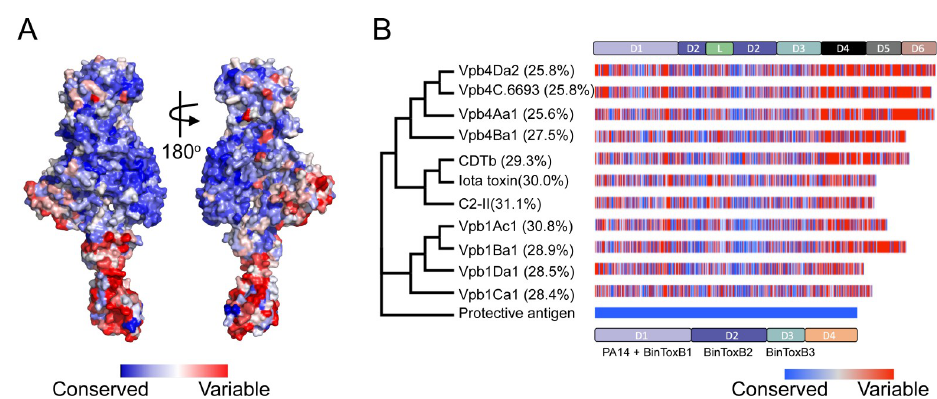
Fig 2. Structural conservation of Vpb4Da2 domains and its evolutionary relationship to Bacterial_exotoxin_B homologs. (A) Mapping amino acid sequence conservations and variabilities from multiple sequence alignments of Vpb4Da2 homologs onto the surface structure of Vpb4Da2. The degree of conservation is color-coded (high conservation = blue; low conservation = red). Higher sequence variability occurs within domains 4–6, whereas more sequence conservation is found in domains 1–3. (B) Phylogenetic tree of relative relationships between Bacterial_exotoxin_B homologs. Tip annotations show protein and global percent identity relative to PA precursor (AAA22637.1). Sequences used in this analysis include Vpb4Da2 (AZJ95709.1), Vpb4C.6693 (this study), Vpb4Aa1 (AEB52299.1), Vpb4Ba1 (OUB778819.1), CDTb (AUA37847.1), Iota toxin component Ib (CAA51960.1), C2 toxin component-II (BAA32537.1), Vpb1Ac1 (AEH05932.1), Vpb1Ba1 (AAR40886.1), Vpb1Ca1 (AAO86514.1), Vpb1Da1 (CAI40767.1), and Protective antigen precursor (AAA22637.1). https://doi.org/10.1371/journal.pone.0260532.g002 indicate that organizationally, the amino-terminal half of Vpb4Da2 is shared among members of the Bacterial_exotoxin_B family (Fig 3A and 3B). The first half of the Vpb4Da2 protein con- tains a domain 1 where the proteolytic site is found to promote oligomerization, a domain 2 comprising the suggested pore-forming stem region, and a domain 3 involved in oligomeriza- tion [22]. Unique to Vpb4Da2 is its domain organization at the carboxyl-terminal end of the protein (Fig 3A). While three carbohydrate binding modules (CBM) are found in the